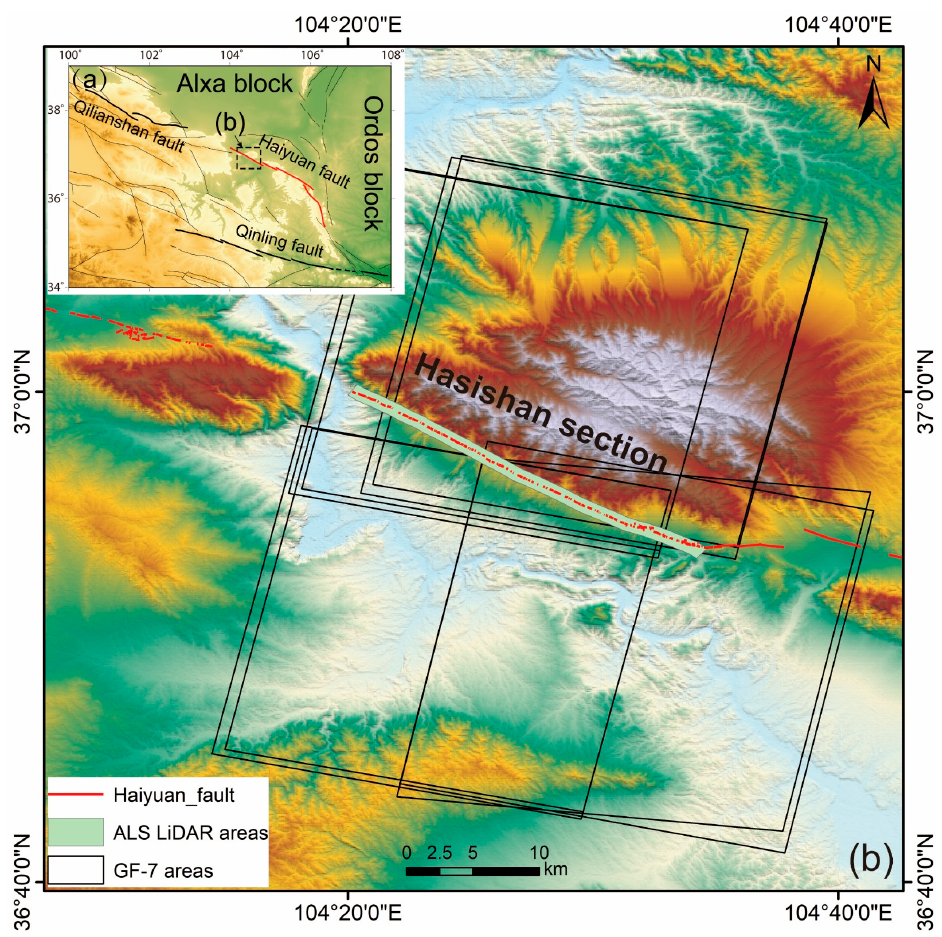
Figure 1. ( a ) Tectonic map of the area around the Haiyuan fault. ( b ) The Hasishan section of the Haiyuan fault and the coverage areas of the GF-7 stereo images.